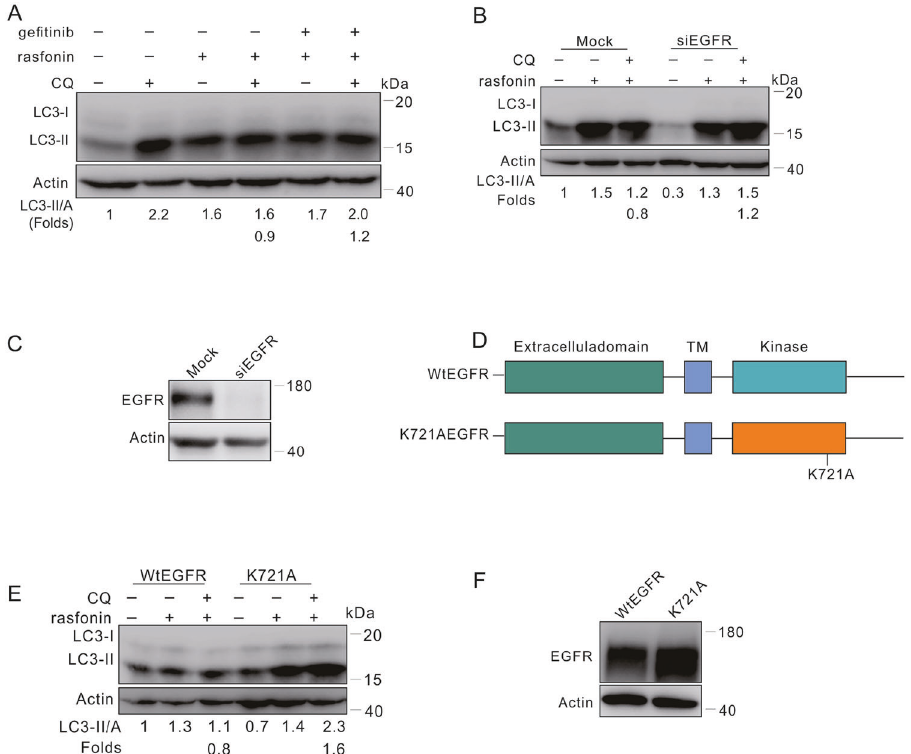
Fig. 5 Knockdown of EGFR reversed the inhibitory effect of rasfonin on autophagy. A ACHN cells were treated with rasfonin (12 μ M) with or without ge fi tinib (5 μ M) for 4 h. B After transfection with the control (Mock) or EGFR siRNA (siEGFR) for 48 h, ACHN cells were treated with rasfonin (12 μ M) for 4 h. Cell lysates in ( A , B ) were analyzed by immunoblotting with the indicated antibodies. C The ef fi ciency of siRNA interference was determined with sample in ( B ). D Schematic representation of the WT EGFR and K721A EGFR. E , F HEK293T cells were transfected transiently with the WT EGFR or K721A EGFR plasmids for 36 h, and treated with rasfonin (12 μ M) for 4 h. Cell lysates were analyzed by immunoblotting with the indicated antibody. Actin was used as a loading control. Similar experiments were repeated at least three